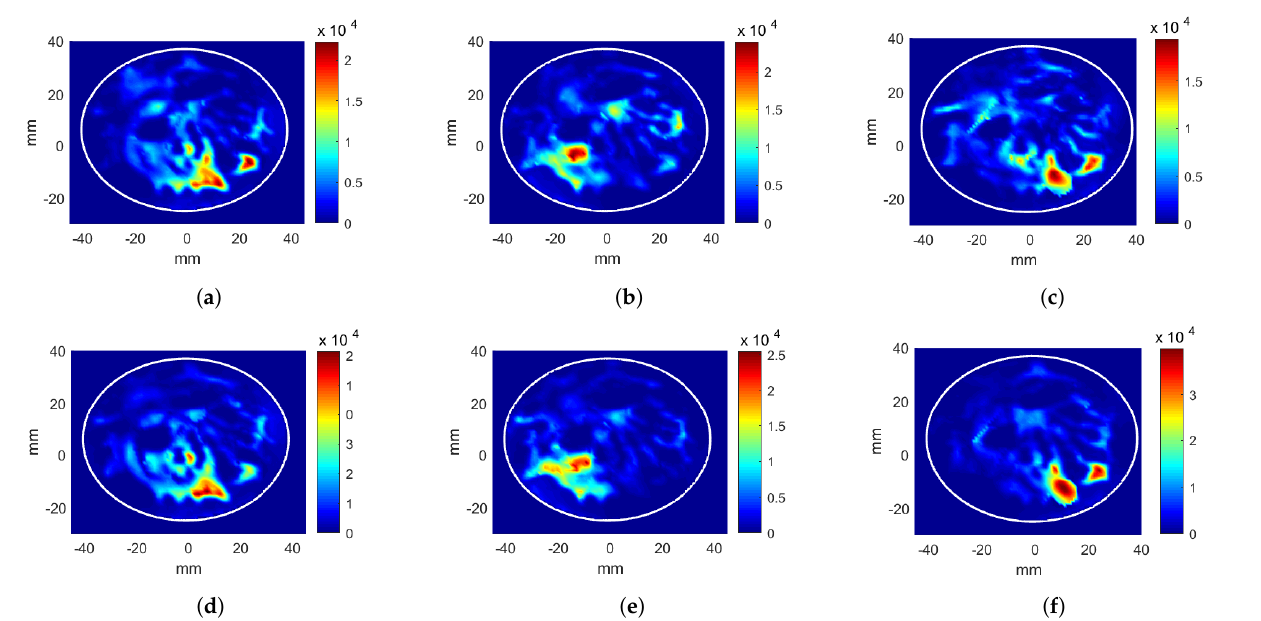
Figure 6. Heating potential distributions (Wm − 3 ) for circular antenna system with excitation pa- rameters obtained from CNN. Phase-only optimization of ( a ) breast without a tumor, target at ( 7, − 11,0 ) mm position, ( b ) breast without a tumor, target at ( − 11, − 7,0 ) mm position, and ( c ) breast with a tumor at ( 11, − 14,0 ) mm position. Phase and power optimization of ( d ) breast without a tumor, target at ( 7, − 11,0 ) mm position, ( e ) breast without a tumor, target at ( − 11, − 7,0 ) mm positionm and ( f ) breast with a tumor at ( 11, − 14,0 ) mm